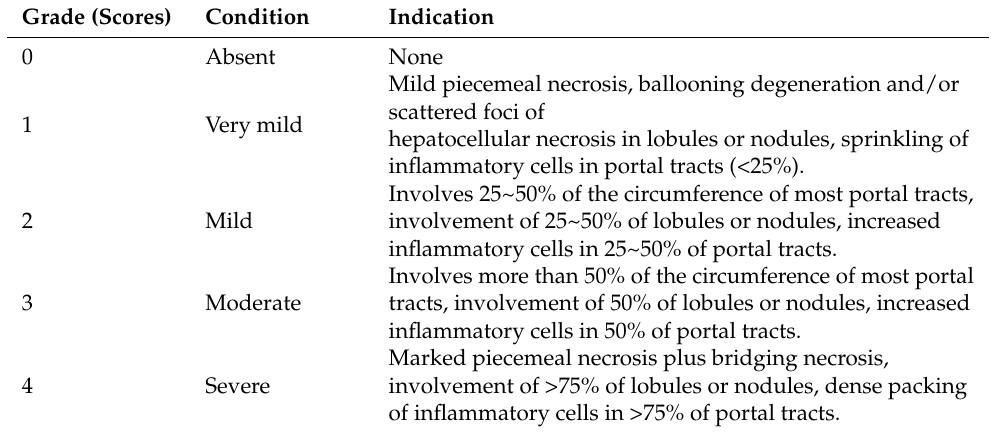
Table 1. Liver histological scoring